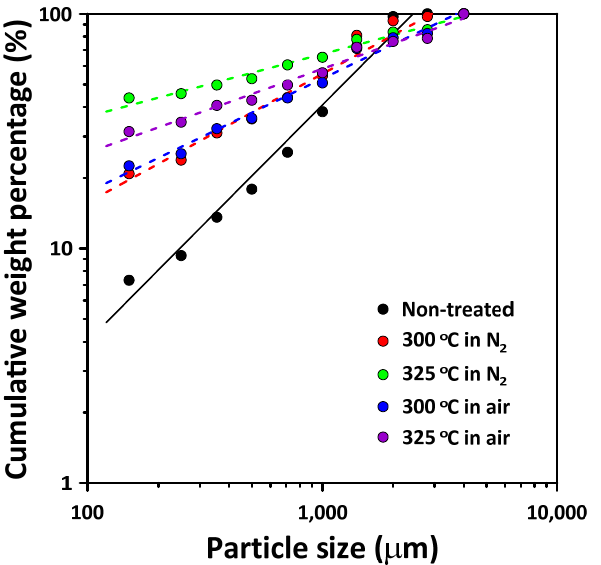
Figure 5. Particle size distributions of the thermally treated PCB particles crushed by shredding and cut crushing according to the different temperatures and gas conditions.